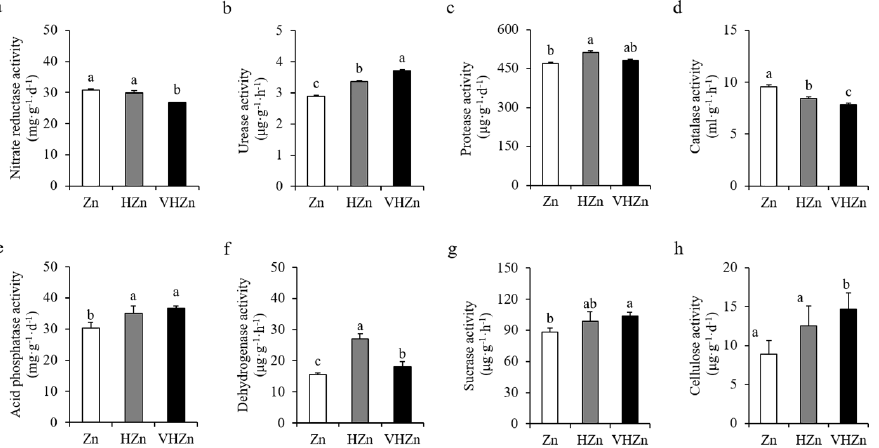
Figure 4. Activities of key enzymes in rice rhizosphere soil with different levels of Zn (Zn: 10 mg . kg −1 soil; HZn: 200 mg . kg −1 soil; VHZn: 400 mg . kg −1 soil). ( a ), Nitrate reductase activity; ( b ), Urease activ- soil; HZn: 200 mg · kg − 1 soil; VHZn: 400 mg · kg − 1 soil). ( a ), Nitrate reductase activity; ( b ), ity; ( c ), Protease activity; ( d ), Catalase activity; ( e ), Acid phosphatase activity; ( f ), Dehydrogenase activity; ( g ), Sucrase activity; ( h ), Cellulose activity. Data are means ± SD of three biological repli- cates. Different letters indicate significant difference at p < 0.05 by Tukey’s test.